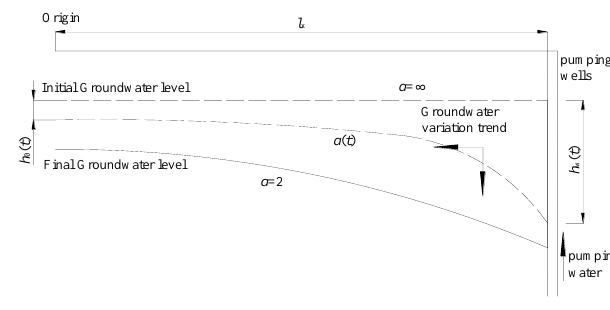
Figure 2. Variation tendency of groundwater level in